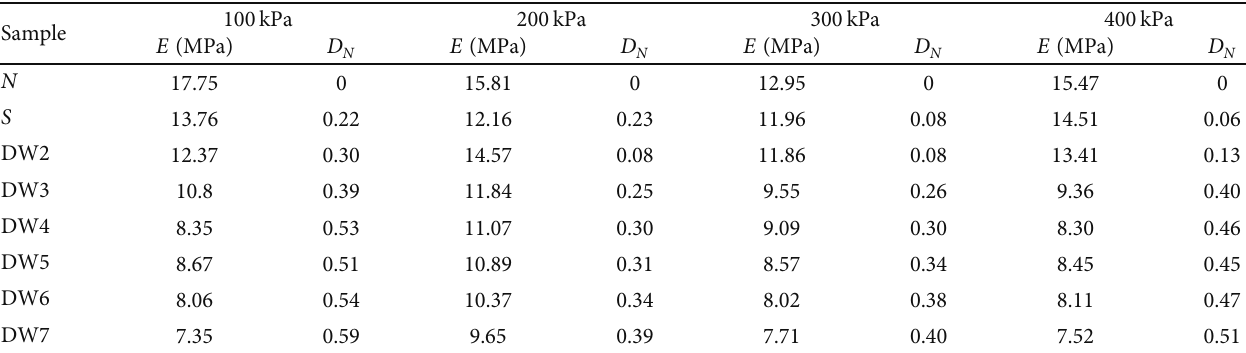
Table 5: Secant modulus and damage variable under a given number of drying – wetting cycles. Sample